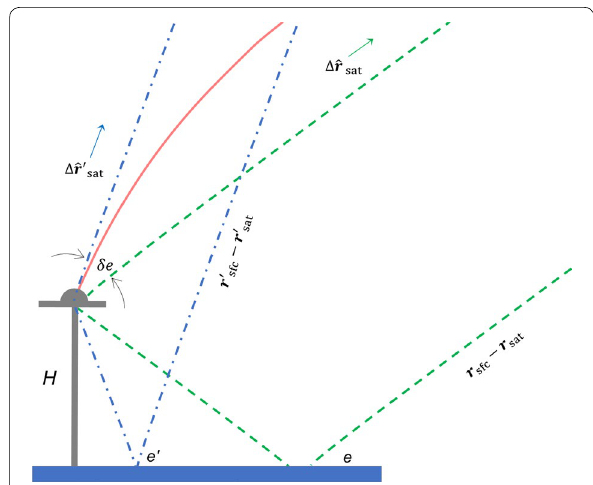
Fig. 1 Geometry of the two rectilinear approaches: rectilinear‑geometric (green dashed line) and rectilinear‑apparent (blue dash‑dot